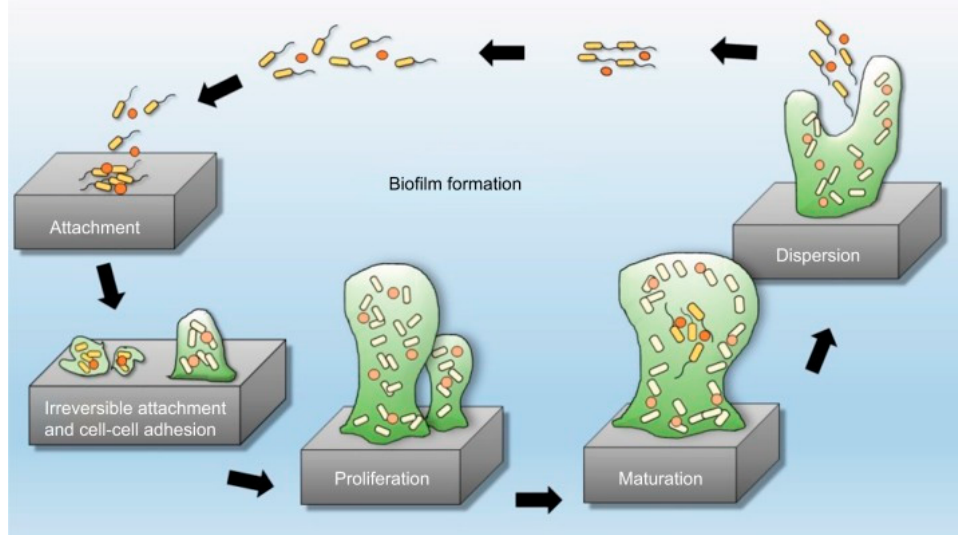
Figure 2. Five stages of biofilm development. Reproduced from [29]. Copyright © 2018 Abu Bakar et al. Reproduced by permission from Perfectus Biomed Limited. http://perfectusbiomed.com/cbe-meeting-anti-biofilm-technologies/.